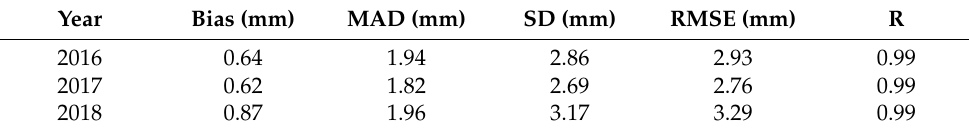
Table 3. Statistics of ERA-Interim global ocean water vapor background precision in 2016–2018.